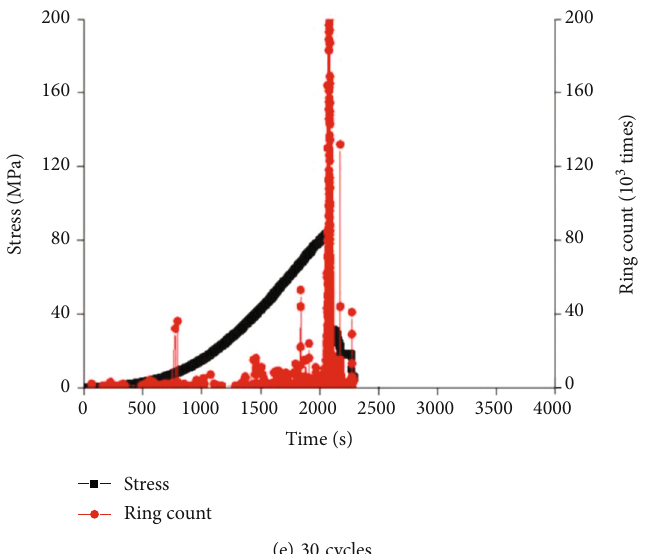
Figure 7: The relationship between stress and the ring count in sandstone as a function of time. The statistical range of the ring count is 0 ~ 200 × 10 3